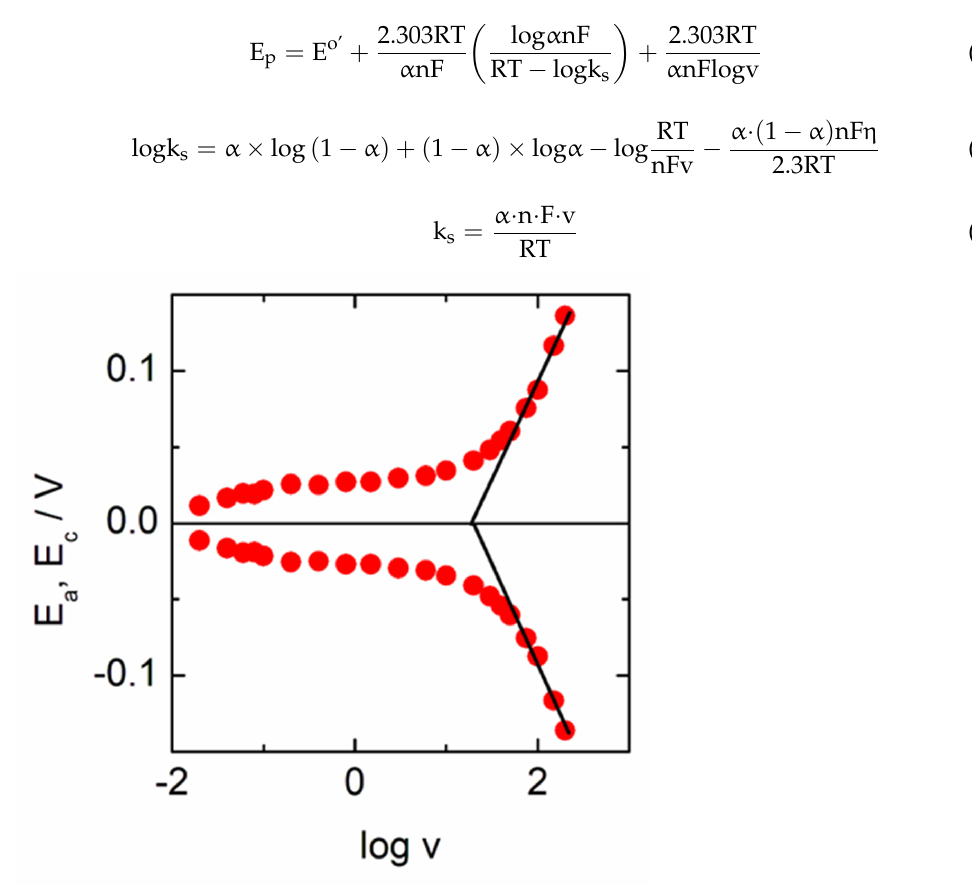
Table 1. Electrochemical parameters obtained from the analysis of the bioconjugates.